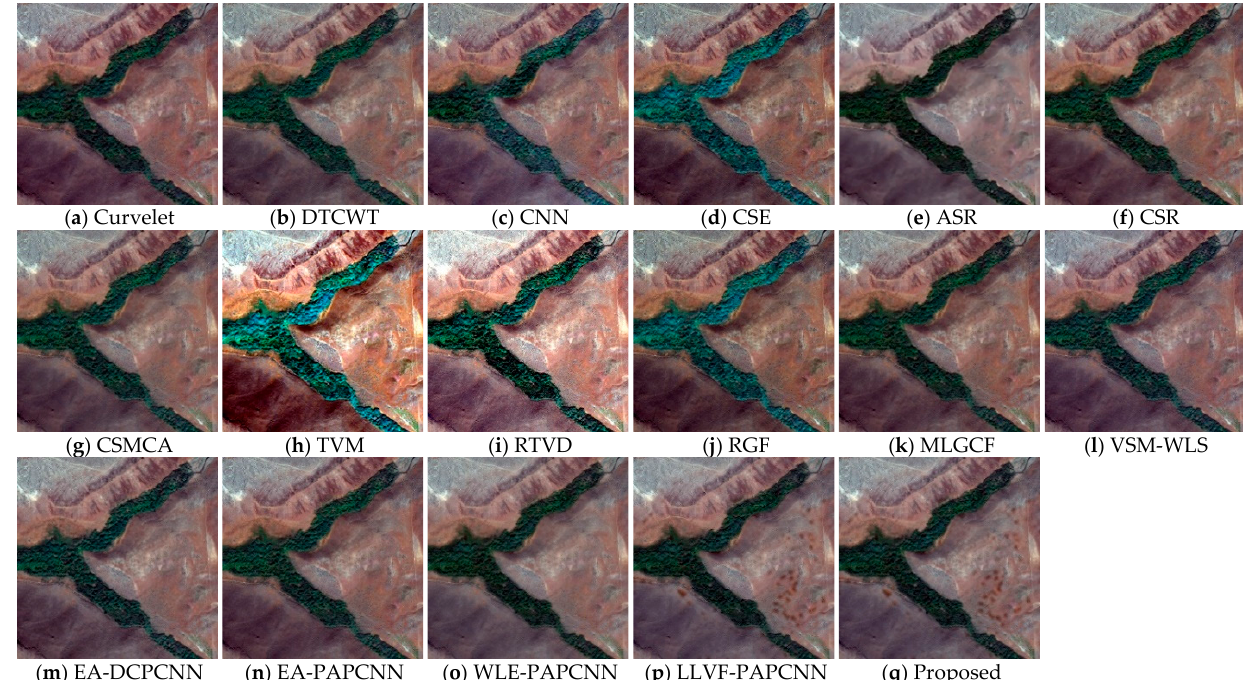
Figure 9. Fusion effect of WorldView-2 image.